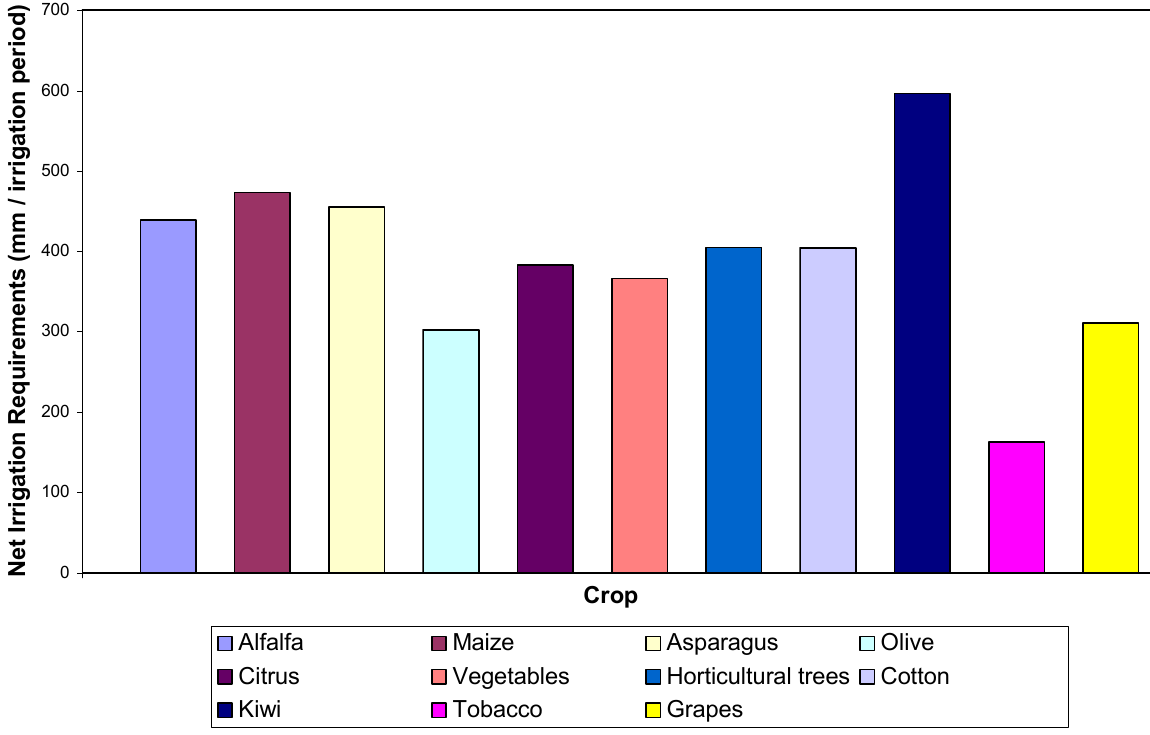
Figure 5. Net Irrigation Requirements for crops in Agrinion area.